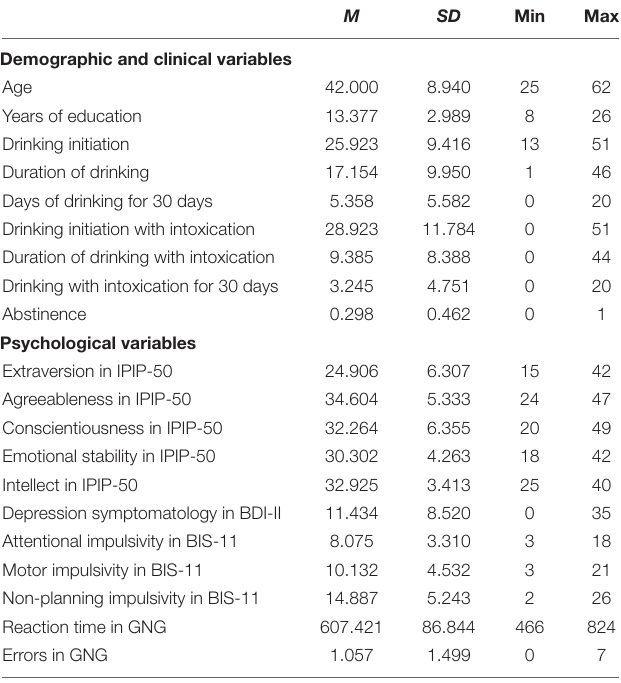
TABLE 1 | Demographic, clinical, and psychological characteristics of participants. M SD Min